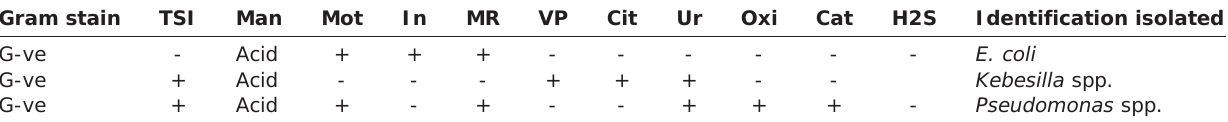
Table-2: Biochemical characteristics of isolated bacteria from bovine mastitis. Gram stain TSI Man Identification isolated